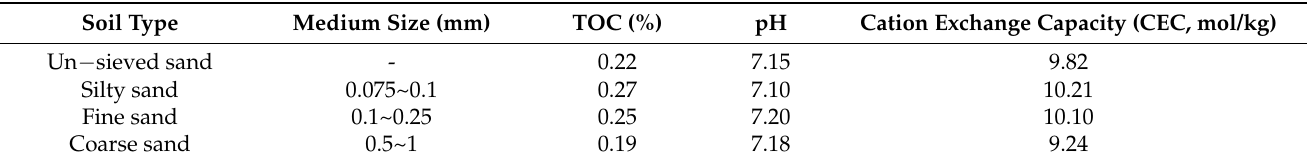
Table 1. Physical and chemical properties of the experimental